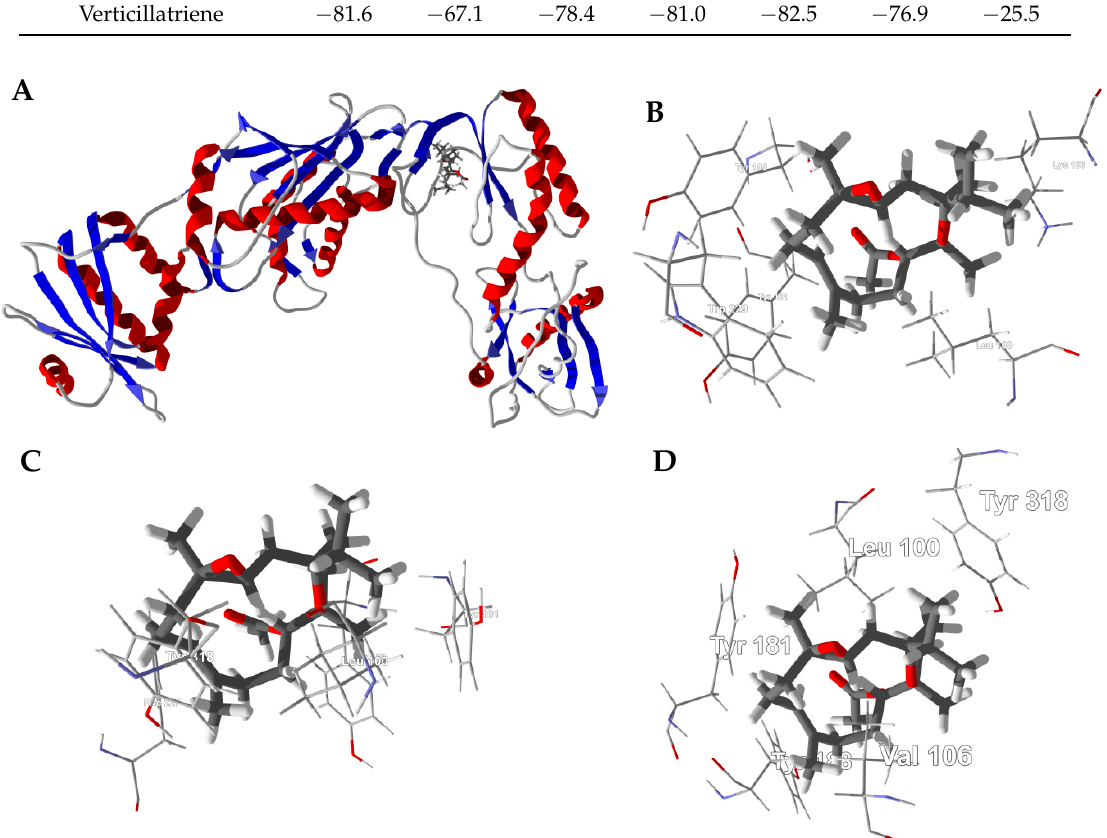
Figure 7. Molecular docking of incensole oxide acetate with HIV-1 reverse transcriptase. ( A ): Ribbon structure of HIV1-RT (PDB 3mee) showing incensole oxide acetate in the active site. ( B ): Key interactions of incensole oxide acetate in the active site of HIV1-RT (PDB 3mee). ( C ): Key interactions of incensole oxide acetate in the active site of HIV1-RT (PDB 3lal). ( D ): Key interactions of incensole oxide acetate in the active site of HIV1-RT (PDB 3t19).